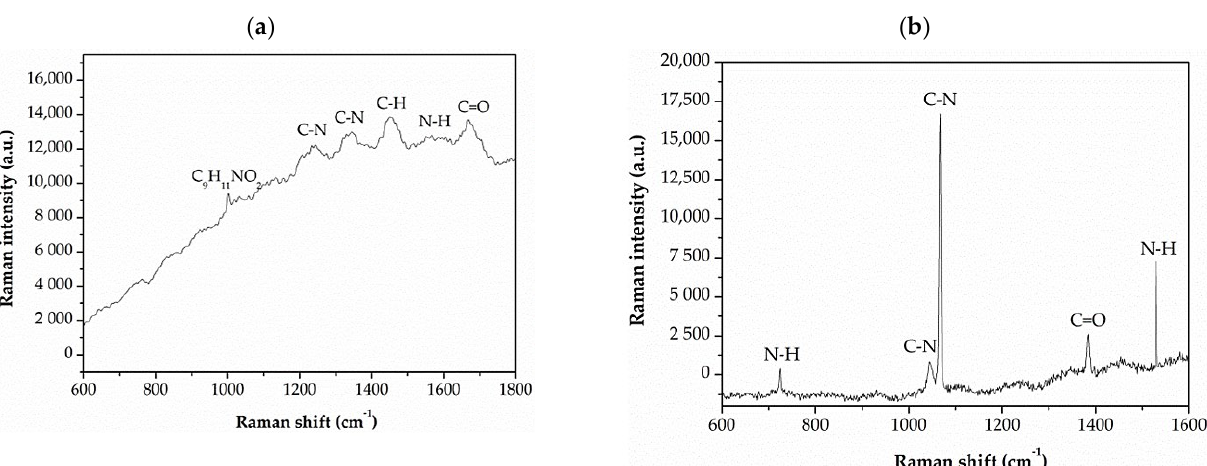
Figure 7. Raman spectra of the casein ( a ) and the casein coating deposited on MgCa2Zn1 ( b ).